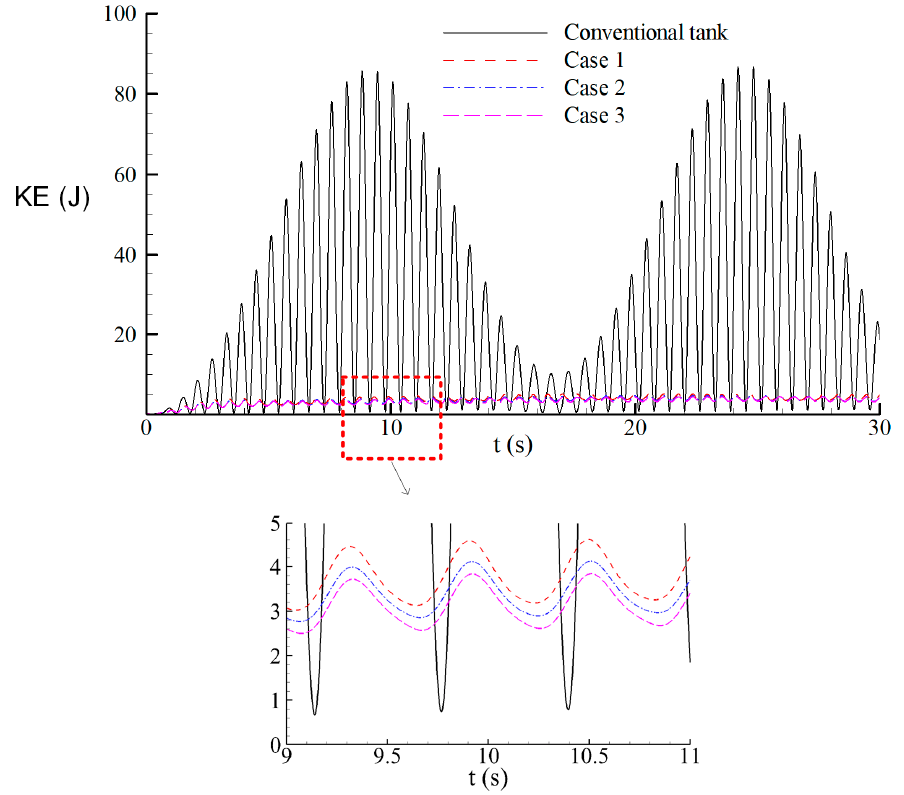
Figure 7. Comparison of the internal kinetic energy of the liquid inside the tank for different slot configurations.